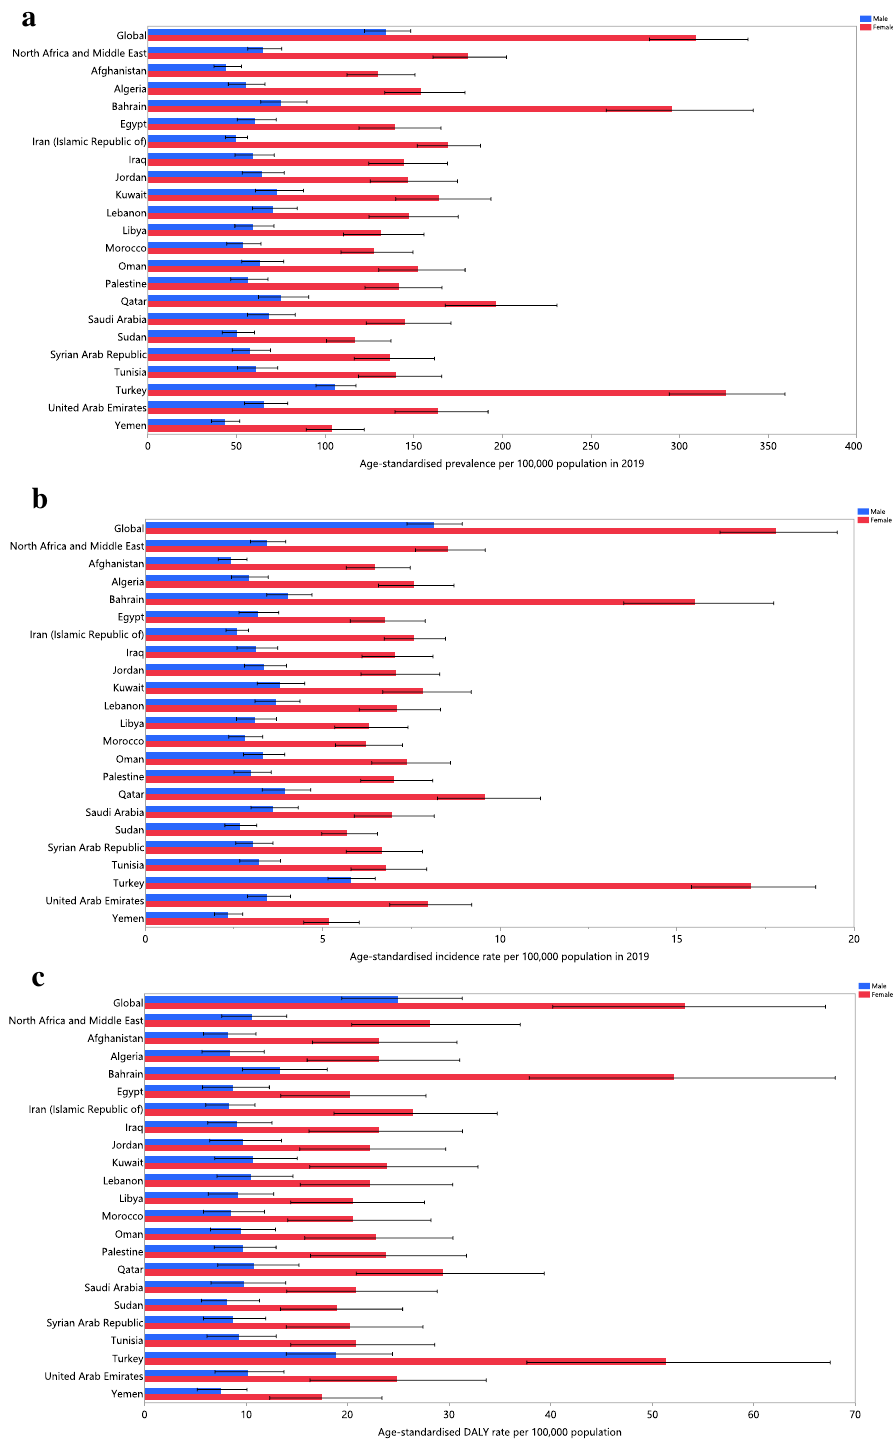
Figure 1. Age-standardised point prevalence ( A ), incidence ( B ), and DALYs ( C ) for rheumatoid arthritis (per 100,000 population) in the Middle East and North Africa region in 2019, by sex and country. DALY disability- adjusted-life-years. (Generated from data available from http:// ghdx. healt hdata. org/ gbd- resul ts-